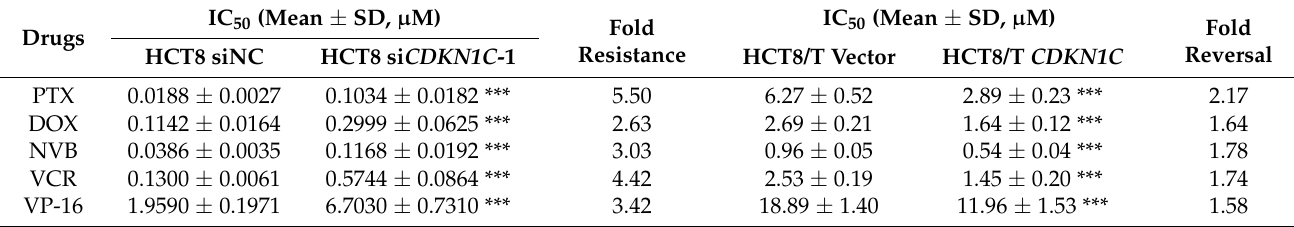
for 48 h, and ( C ) in HCT8/T cells treated with CDKN1C for 48 h. Detailed information about Western Blot can be found at Supplementary Materials. ( B ) Silencing of CDKN1C desensitized HCT8 cells to chemotherapeutic drugs, and ( D ) Overexpression of CDKN1C resensitized HCT8/T cells to chemotherapeutic agents. Cells were treated with drugs at gradient concentrations for 72 h after transfection with CDKN1C or si CDKN1C -1 for 24 h, cell survival curves and IC 50 values of multiple chemotherapeutic drugs were measured by CCK8 assay. All experiments above were repeated three or more times independently and values are shown as mean ± SD. * p < 0.05; ** p < 0.01; *** p < 0.001. Table 2. The effect of CDKN1C on sensitivity of HCT8 and HCT8/T cells to chemotherapeutic